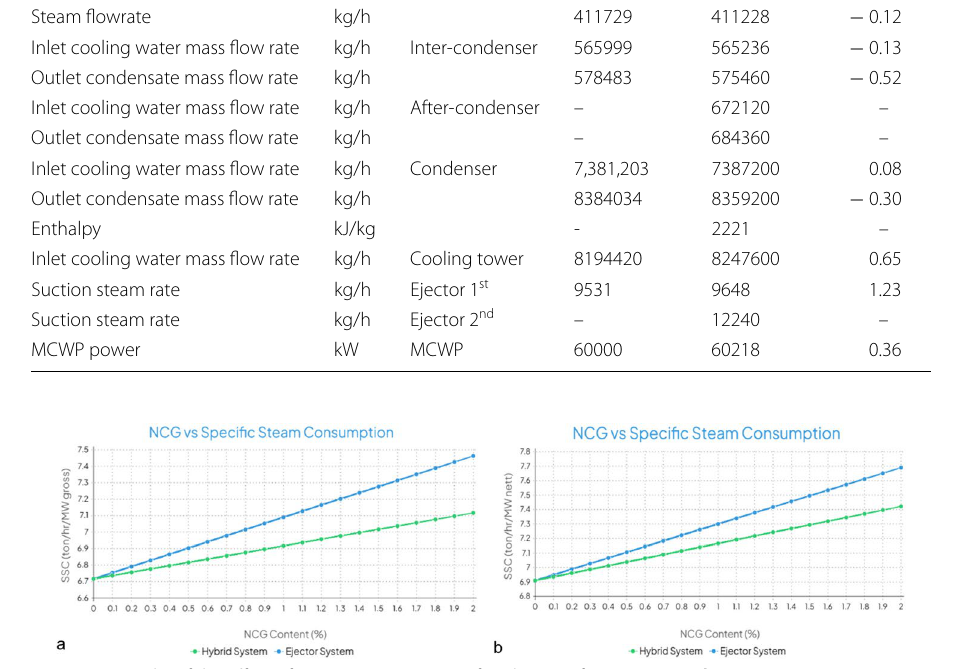
Fig. 18 Graphs of the effect of NCG content on SSC of each type of GRS a SSC gross b SSC